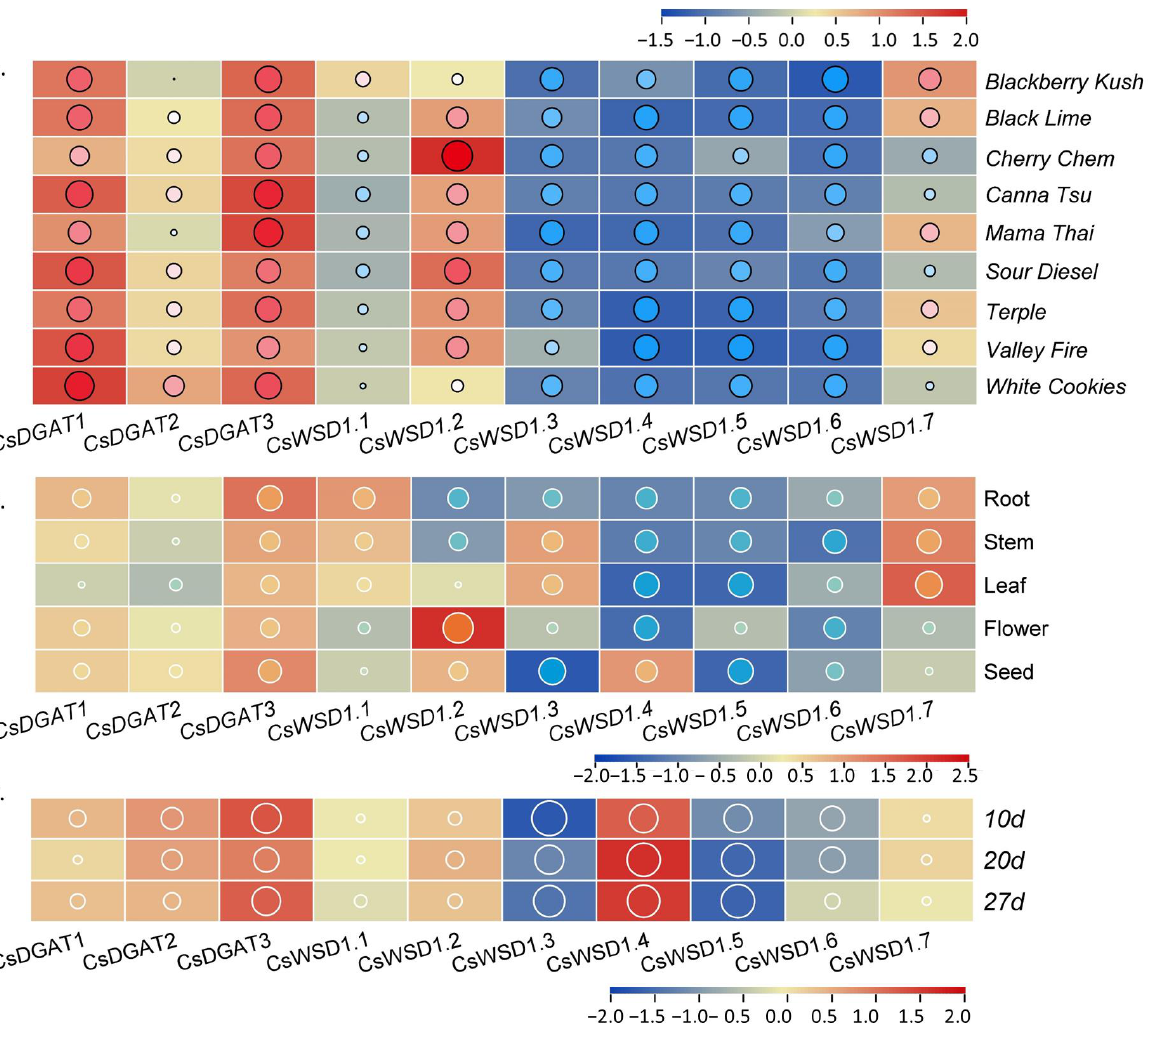
Figure 6. Normalized expression profiles of CsDGAT family genes in C. sativa. ( A ) Normalized expression profiles of CsDGAT genes in female inflorescences of ten hemp varieties based on transcriptome expression data. ( B ) Normalized expression profiles of CsDGAT genes in different tissues of identically hemp varieties based on transcriptome expression data. Each column represents a different tissue of hemp. ( C ) Normalized expression profiles of CsDGAT genes in developing seeds at different growth stages after fertilization based on transcriptome expression data. Each column represents a different growth stage of hemp. The size of circles with different colors represents the value of expression quantity. The bottom bar indicates high to low normalized expression data (red to blue).